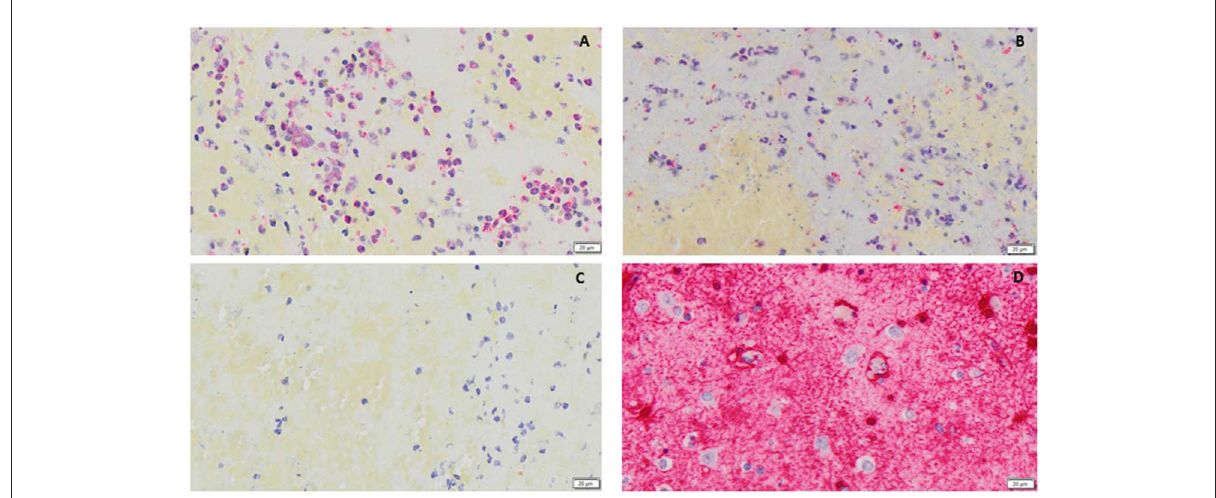
FIGURE2 (A, B) examples of S100b (red immunostaining) in clots, respectively from a patient with (A) and without (B) Post-thrombectomy Intracranial Hemorrhage are shown. In (C) a negative control is shown, while in (D) positive control tissue (human entorhinal brain cortex) is shown. Nuclei are stained blue (counterstaining with haematoxylin). All images were captured using the 20 × objective (scale bar 20 µ m).